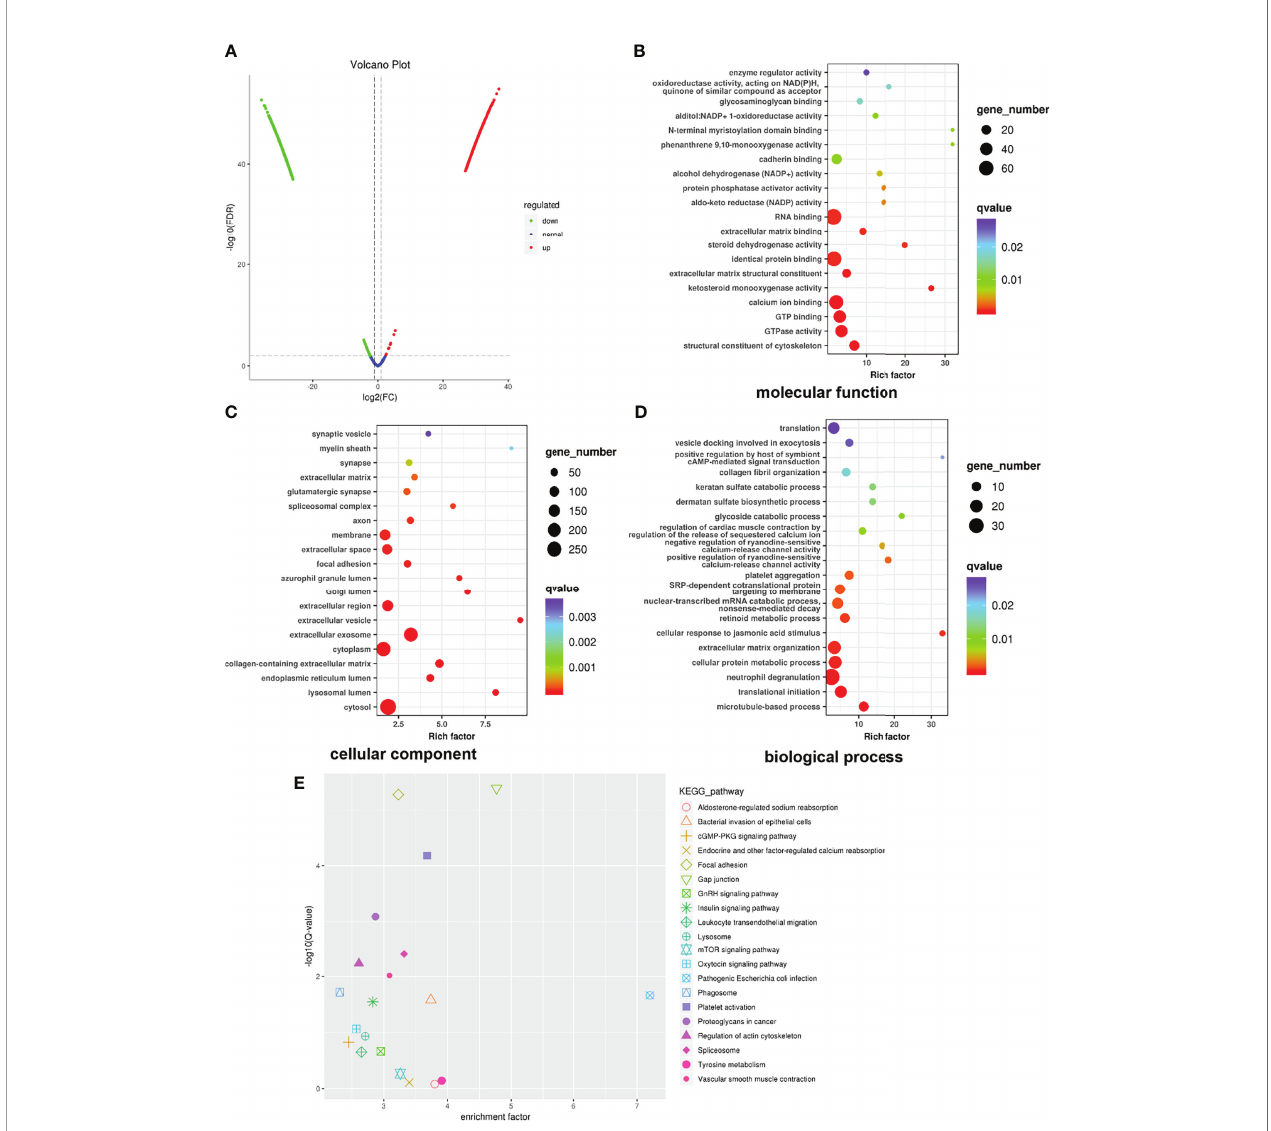
FIGURE 3 | Global pro fi le of exosomal proteins. (A) Volcano plot showing protein expression. (B – D) GO enrichment analysis of upregulated proteins exclusively identi fi ed in exosomes. The horizontal coordinate shows the enrichment factor, and the vertical coordinate represents the protein-enriched secondary GO function. The size and color of the dots indicate gene number and Q-value. (E) KEGG pathway enrichment of signi fi cantly upregulated proteins. GO, Gene Ontology; KEGG, Kyoto Encyclopedia of Genes and